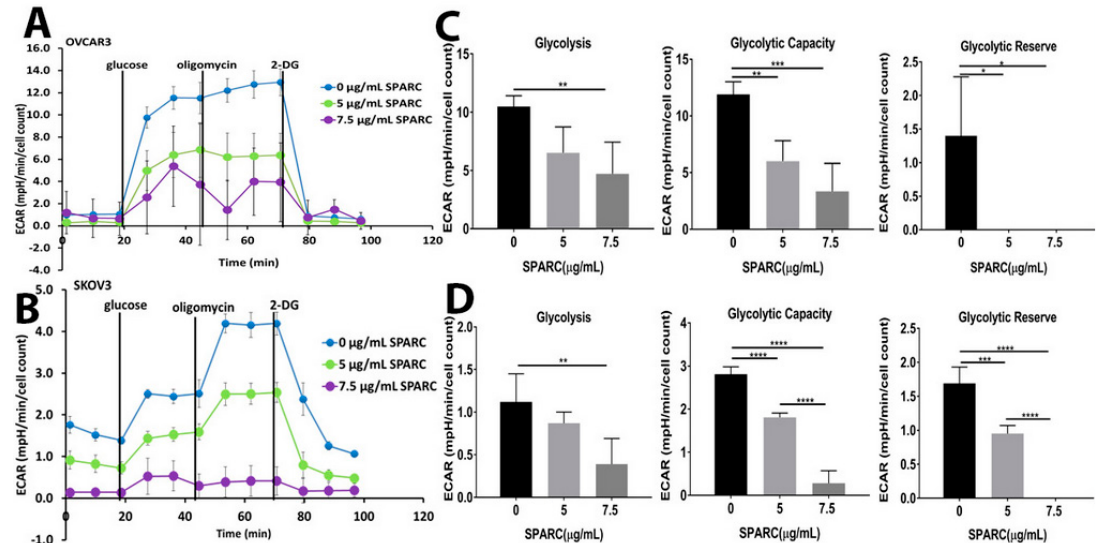
Figure 3. Effect of SPARC on glycolysis: ( A , B ) ECAR Seahorse tracing of a representative of three experiments of OVCAR3 and SKOV3 treated with the indicated concentrations of SPARC for 24 h and were subjected to glycolysis stress assay as described in Materials and Methods. ( C , D ) Bars represent mean ± SEM of glycolysis, glycolytic capacity and glycolytic reserve of experiments described in ( A , B ) (n = 5/experimental condition in each experiment) corrected to the number of viable cells counted by trypan blue exclusion. * p < 0.05, ** p < 0.01, *** p < 0.001, and **** p < 0.0001, respectively, one-way ANOVA with multiple comparisons and Tuckey’s post-hoc test.